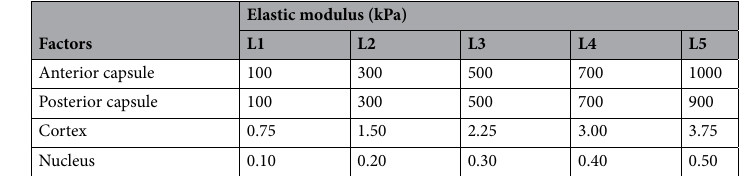
Table 1. Material properties for the different levels (L) of the DoE. Four factors and five levels were considered for two different geometries according to age (17 and 29 y/o).